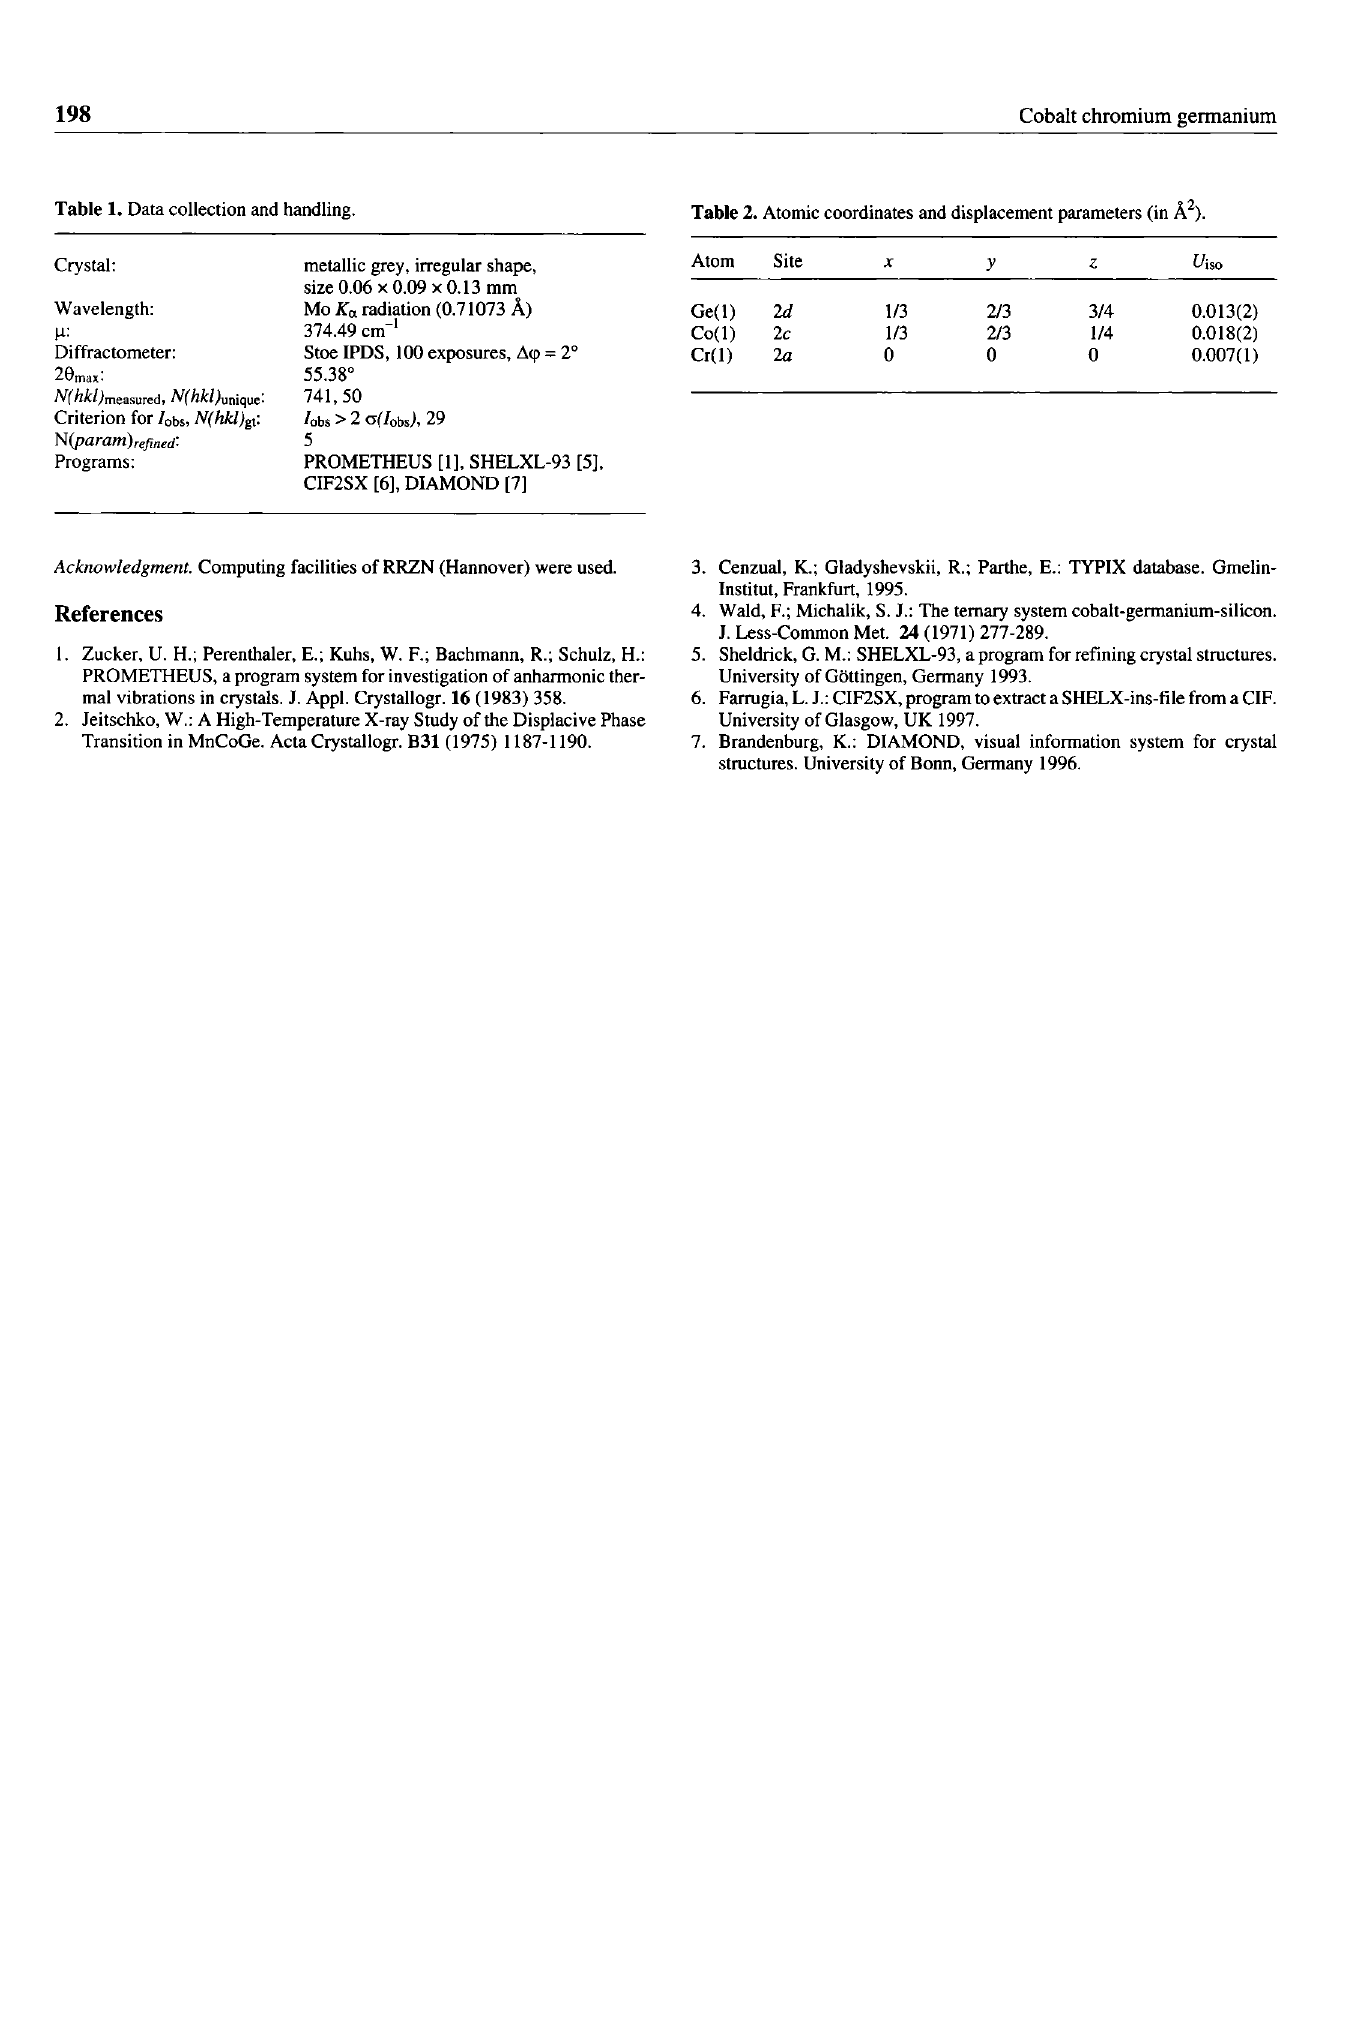
Table 1. Data collection and handling. Table 2. Atomic coordinates and displacement parameters (in Ä 2